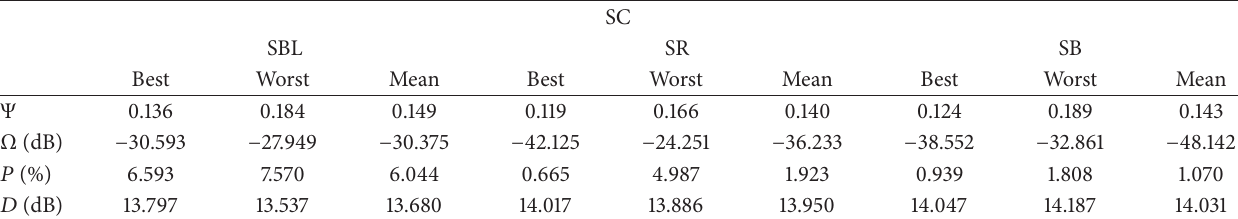
Table 3: Calculated benchmark parameters of DE algorithm outputs for SC.